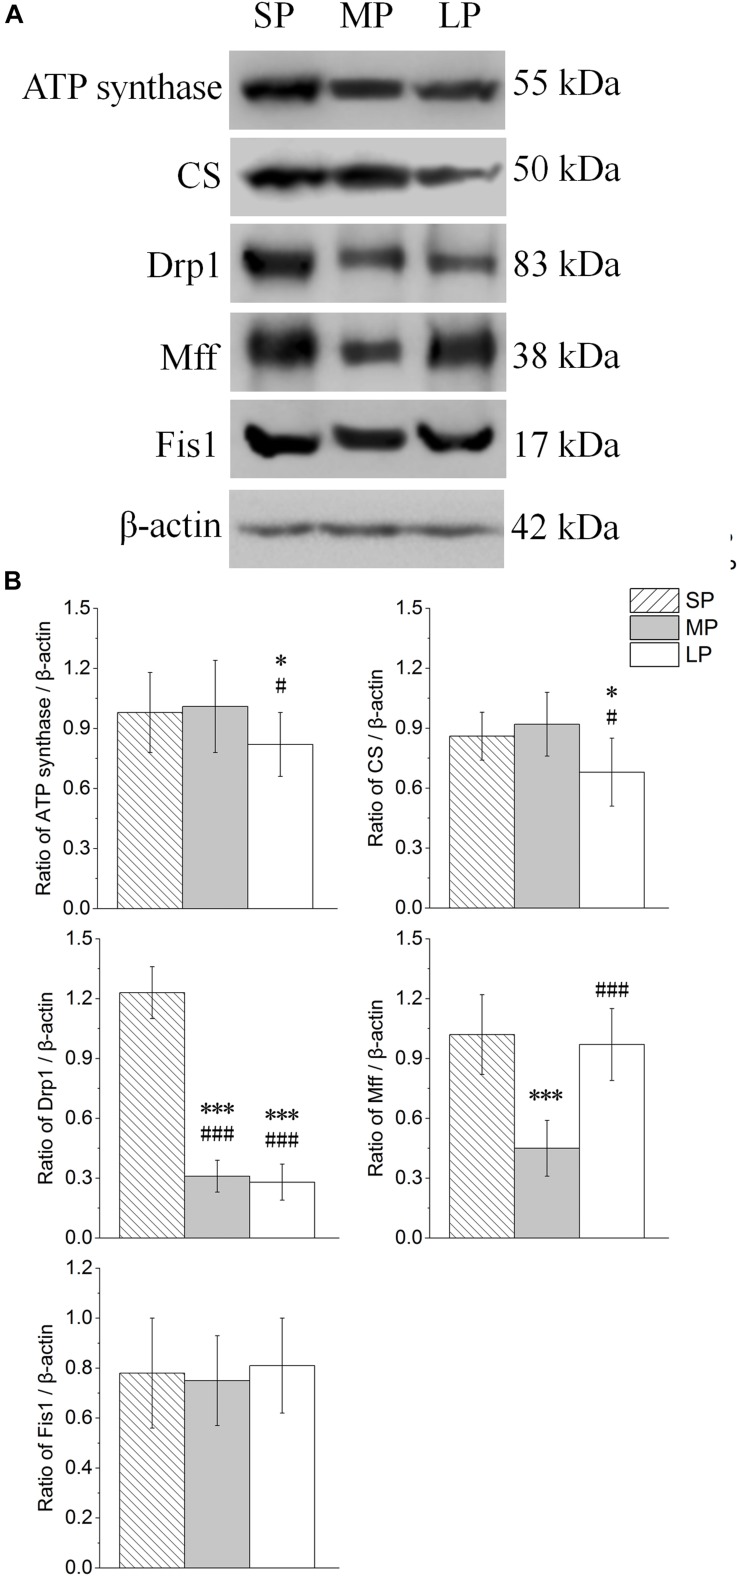
Changes in protein levels of ATP synthase, CS, Drp1, Mff, and Fis1 in HG of hamsters in three different photoperiodic groups. (A) Representative immunoblots of ATP synthase, CS, Drp1, Mff, Fis1, and β-actin in three different photoperiodic groups. (B) Ratio of ATP synthase, CS, Drp1, Mff, Fis1 to β-actin in HG of hamsters in three different photoperiodic groups. Values are means ± SD. n = 10. SP, short photoperiod; MP, moderate photoperiod; LP, long photoperiod. ∗P < 0.05, ∗∗∗P < 0.001 compared with SP; #P < 0.05, ###P < 0.001 compared with MP.